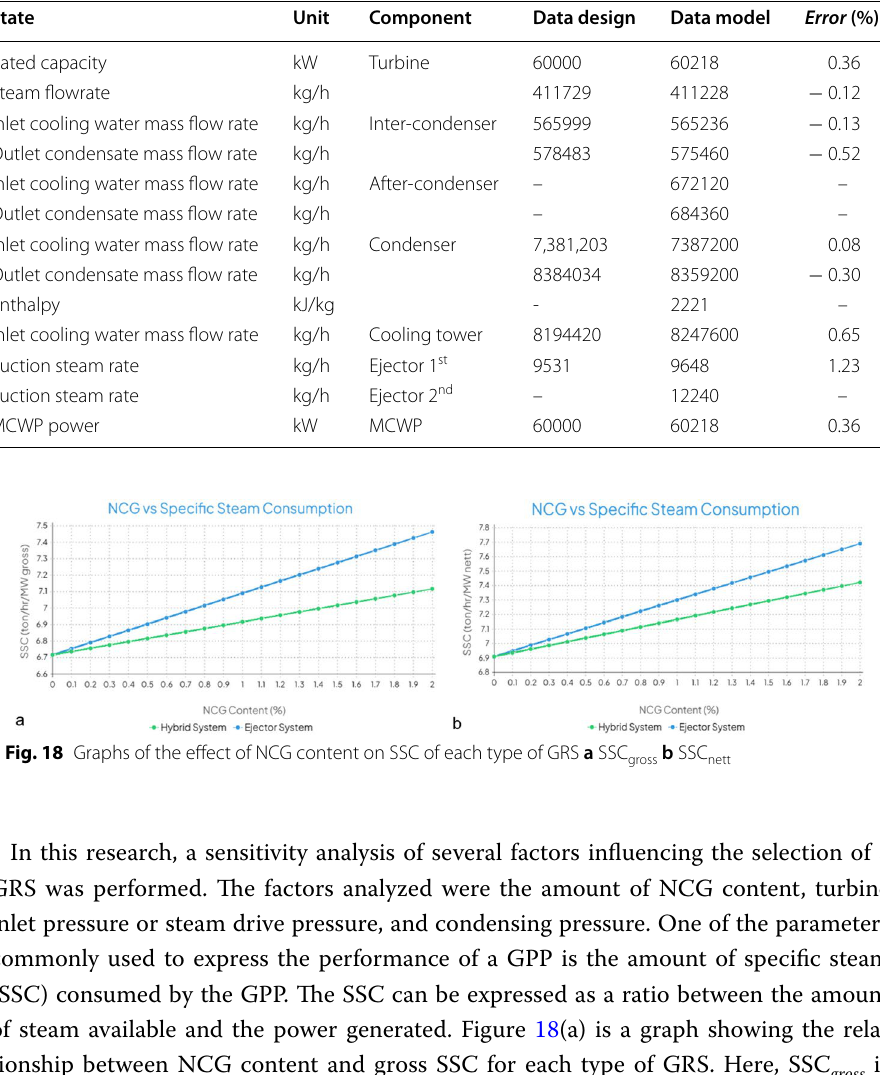
Table 4 Validation results for our model using data from Kamojang GPP’s Unit 4